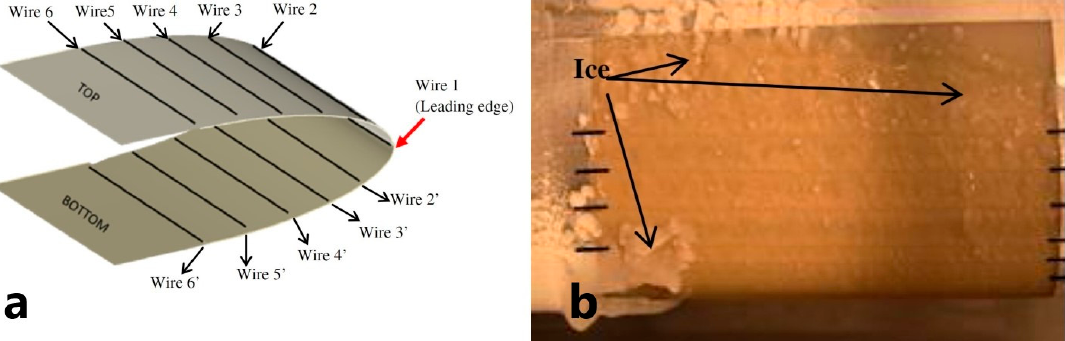
Figure 2. ( a ) Schematic of a composite with integrated thermal elements, ( b ) De-icing behavior of the composite in icing test. (Reprinted with permission from Elsevier, copyright 2013) [40].